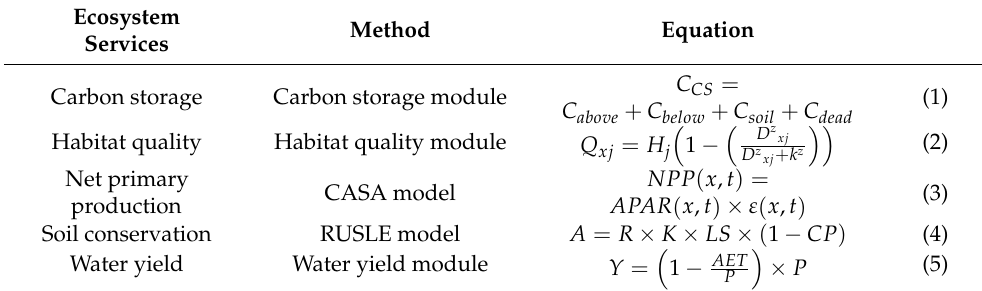
Table 1. Evaluation methods and indicators for of each ecosystem